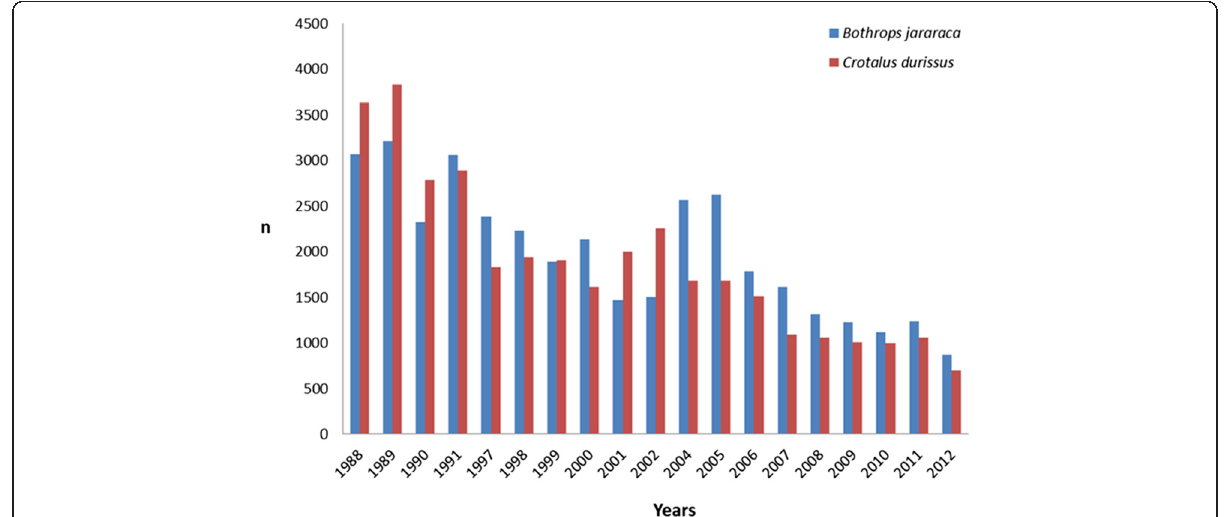
Figure 1 Entry of Bothrops jararaca and Crotalus durissus (Serpentes, Viperidae) per year at Butantan Institute, São Paulo, SP,